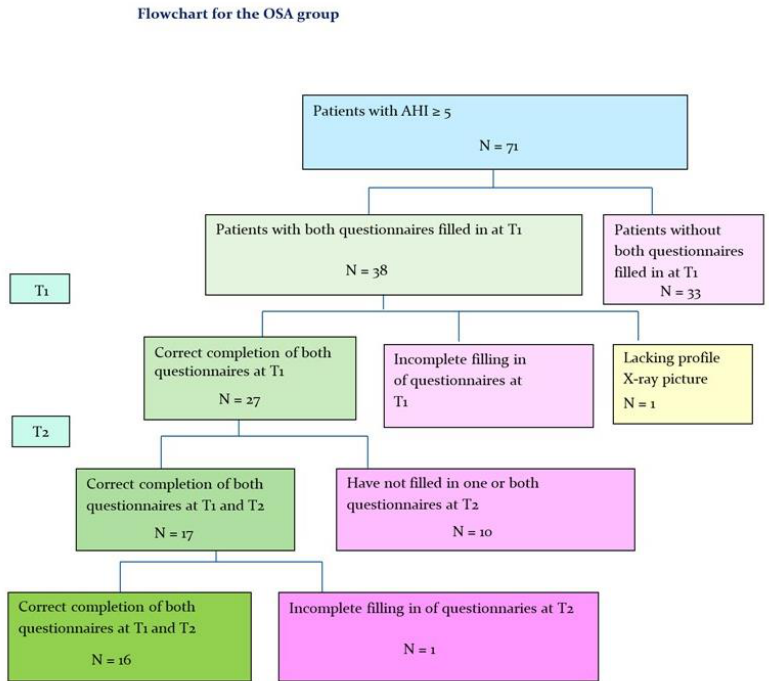
Figure 1. Flowchart for the OSA group. T1: Before treatment with MAD; T2: After treatment with MAD.